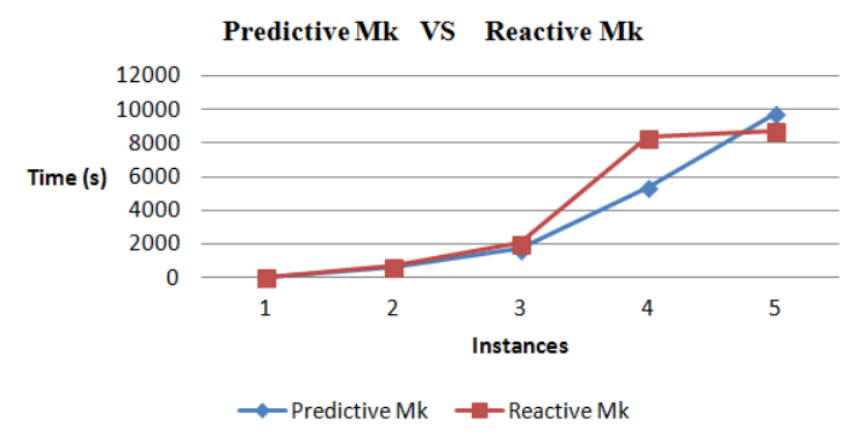
Figure 16. Makespan (Mk) found by EasySched.